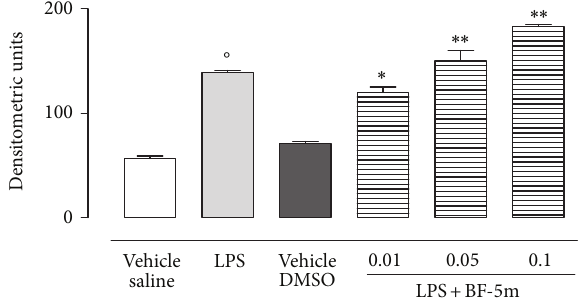
Figure 9: Western blotting for Bcl-xl. Expression of the antiapoptotic protein Bcl-xl in eye tissue of rats treated with LPS or LPS+BF-5m (0.01; 0.05; 0.1 𝜇 M/rat). Values are mean ± SEM of 𝑛 = 6 observations for each group. ∗ 𝑃 < 0.05 and ∗∗ 𝑃 < 0.01 versus LPS-treated rats; ∘ 𝑃 < 0.01 versus vehicle (saline)